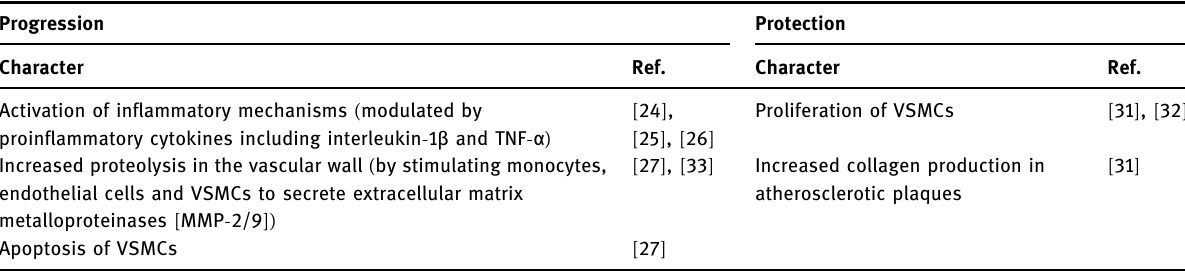
Table 1: Participation of OPG in the pathogenesis of abdominal aortic aneurysms Progression